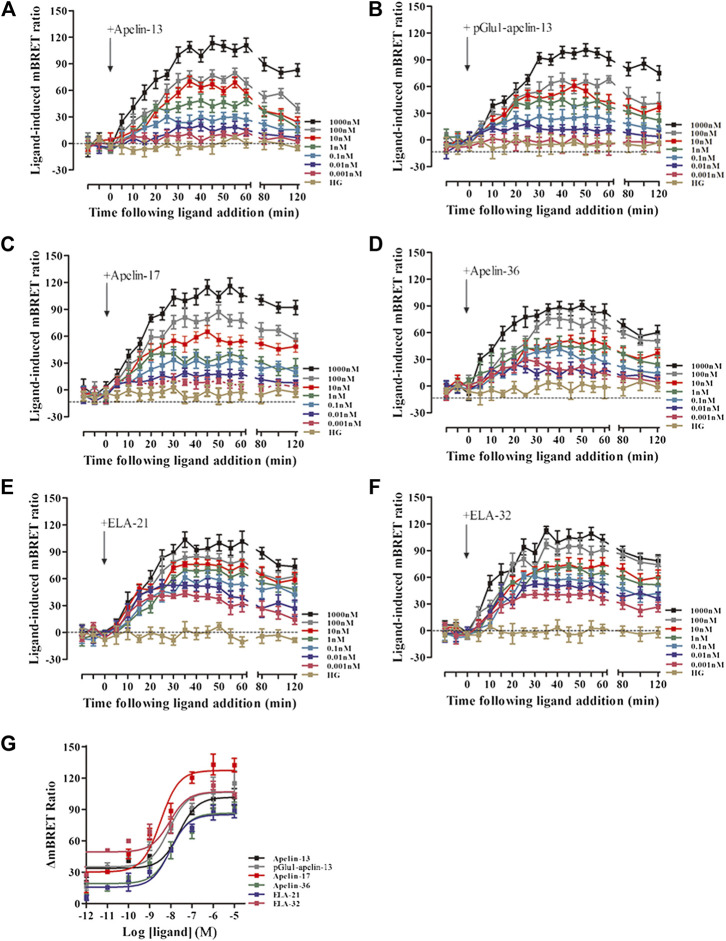
The time-response curve (A–F) and dose-response curve (G) of interactions between β-arrestin1 and AP2 induced by APJ upon activation by the six agonists in different concentrations, obtained from real-time dynamic BRET determination. p < 0.05 was considered as statistically significant. Control group (HG, Cells were stimulated with high glucose). The BRET assay to measure the six peptide (0.001–1,000 nM) induced concentration-response curves of β-arrestin 1 and β2-adaptin recruitment to APJ at 30 min post-stimulation (G). The data represent means ± SEM of four independent experiments. Statistical analysis (Supplementary Table S7).